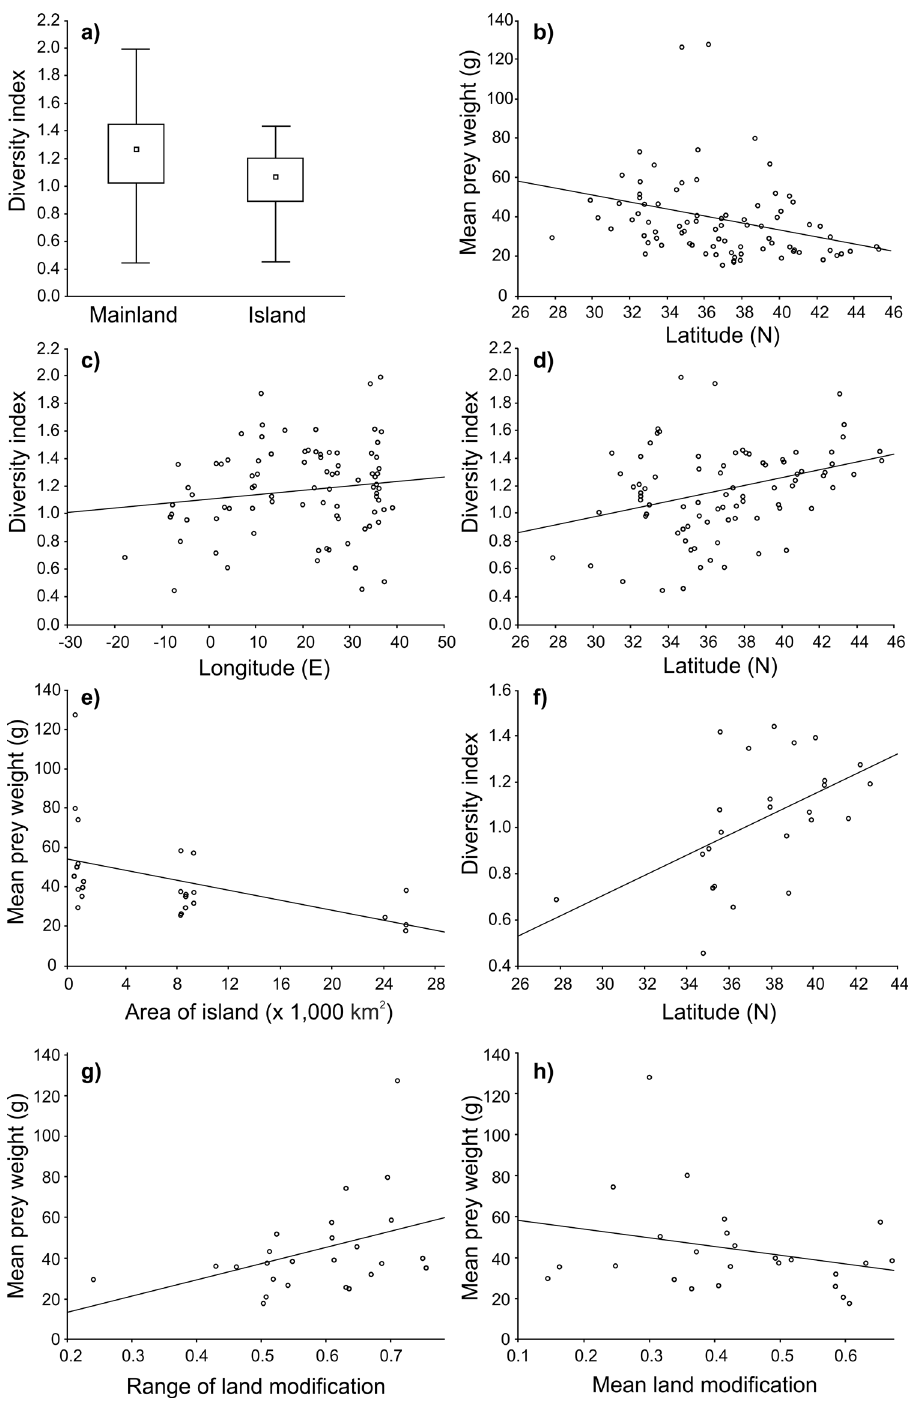
Figure 3. ( a ) Comparison between the diversity of mammalian prey in Barn owl diet on islands and diversity on the continent. The effect of latitude on mean prey weight ( b ) and the effect of ( c ) longitude and ( d ) latitude on mammalian Barn owl prey diversity for the whole dataset (n = 85). ( e ) The effect of the area of the island on mean prey weight and ( f ) the relationship between latitude and mammalian prey diet diversity on islands (n = 25). In boxplot, small squares—medians, boxes—25–75% of data, whiskers—non-outlier